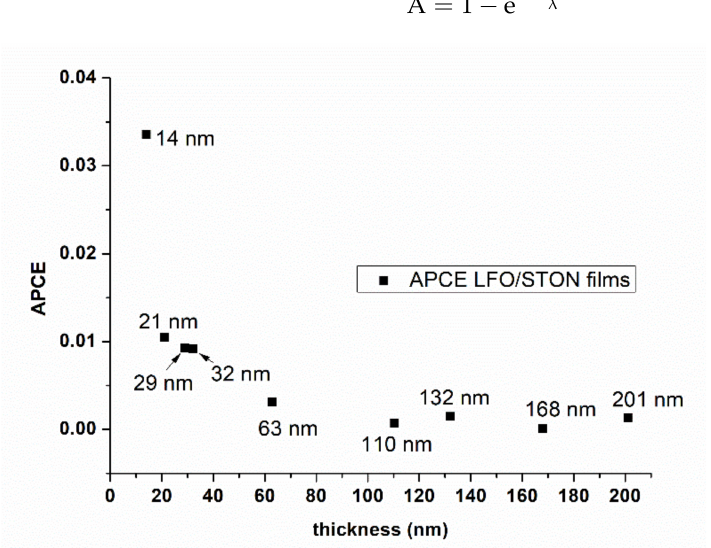
Figure 6. APCE efficiency as a function of films thickness. The incident power at the films’ surface was 883 mW/cm 2 , the irradiated spot size being 0.5 mm 2